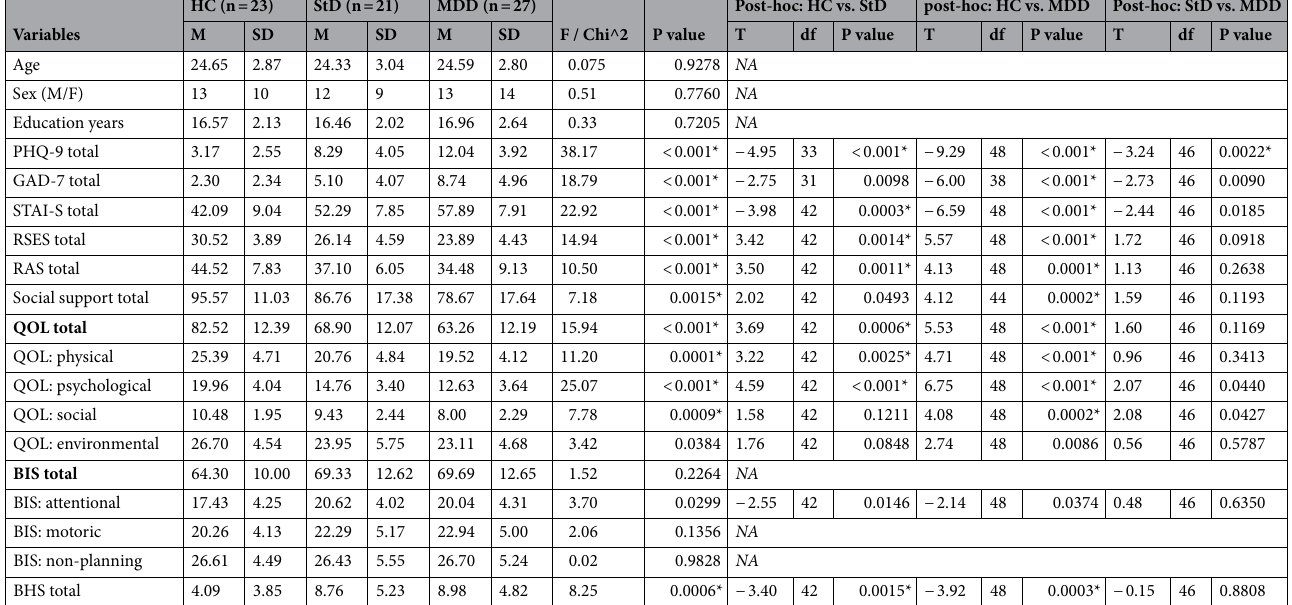
Table 1. Demographic and clinical characteristics. BHS Beck hopelessness scale, BIS Barratt impulsiveness scale, GAD-7 generalized anxiety disorder-7, HC healthy controls, MDD major depressive disorder, M mean,